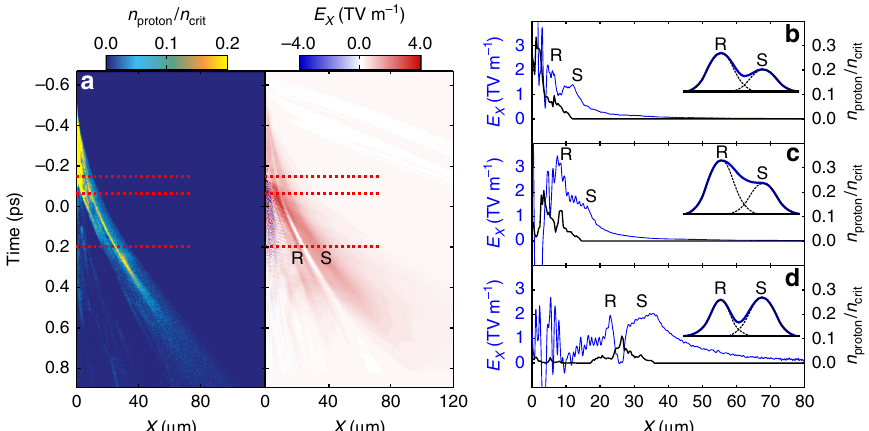
Fig. 6 Simulation results illustrating the hybrid acceleration scheme. a Proton density ( n proton ) and longitudinal electrostatic fi eld ( E X ; along the laser axis) as a function of X and time (where time t = 0 corresponds to the peak of the pulse arriving at the target) for the interaction of a 0.4 ps, 2 × 10 20 W cm − 2 laser pulse with a ‘ = 75 nm plastic foil. The three dotted lines correspond to the example times considered in b – d , from top to bottom, respectively. b – d Longitudinal electric fi eld (blue) and proton density (black) at b t = − 0.15 ps, c t = − 0.05 ps and d t = 0.2 ps. Peaks R and S are the RPA and TNSA fi elds, respectively. The insets in b – d schematically illustrate the evolution of the dual-peaked structure